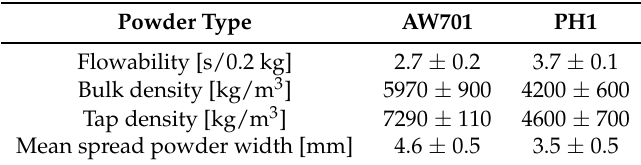
Table 1. Technological properties of AW701 powder mixture and PH1